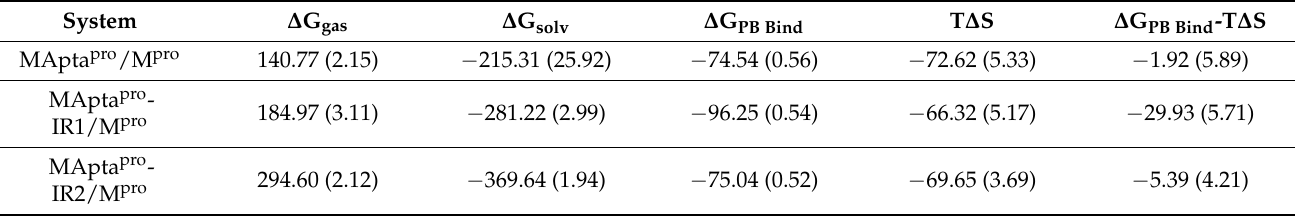
Data are reported as mean and SD of five snapshots extracted from the clustered representative structure. All units are reported in Table 4. Summary of M pro -Aptamers binding affinities. The Nmode was used to compute the en- tropy contribution.